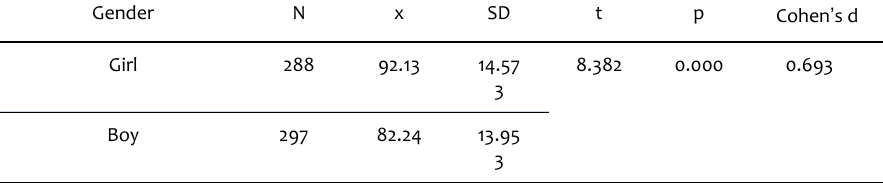
Table 1. Students' reading motivation scores in relation to gender